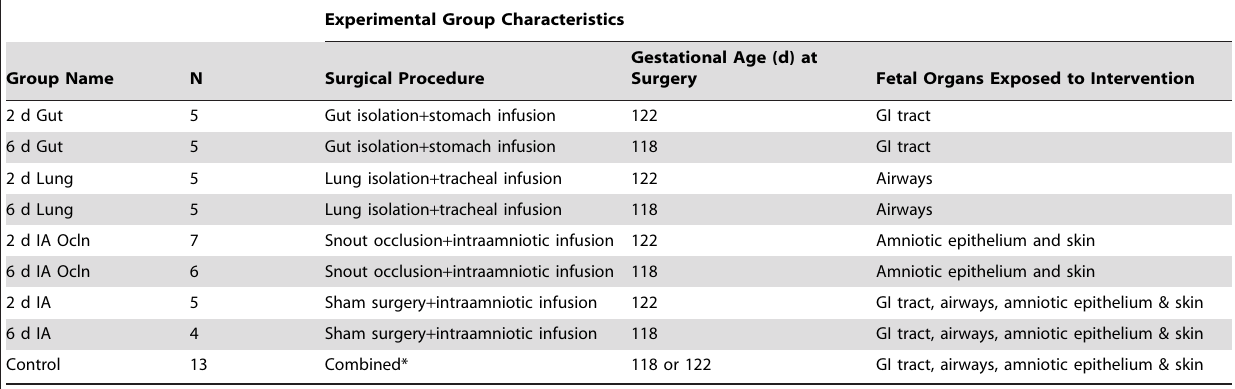
Experimental Group Characteristics